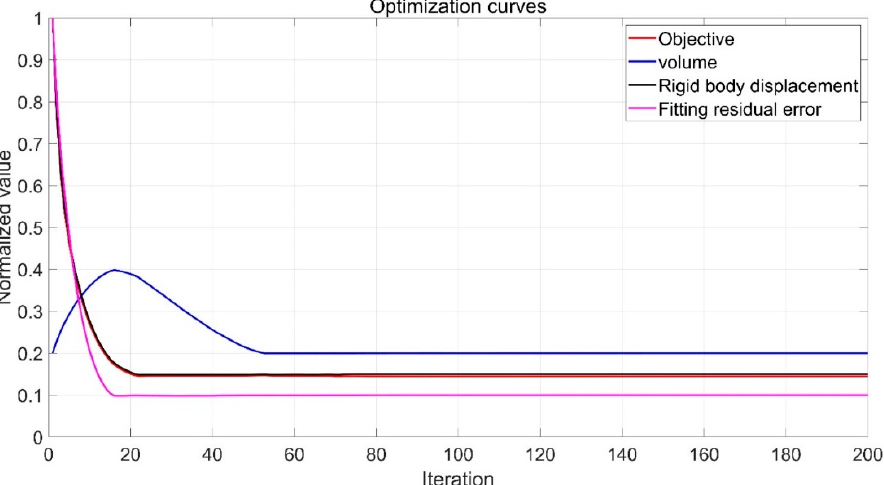
Figure 14. Iterative curves of the normalized objective and constraints in the vertical condition of the optical axis.